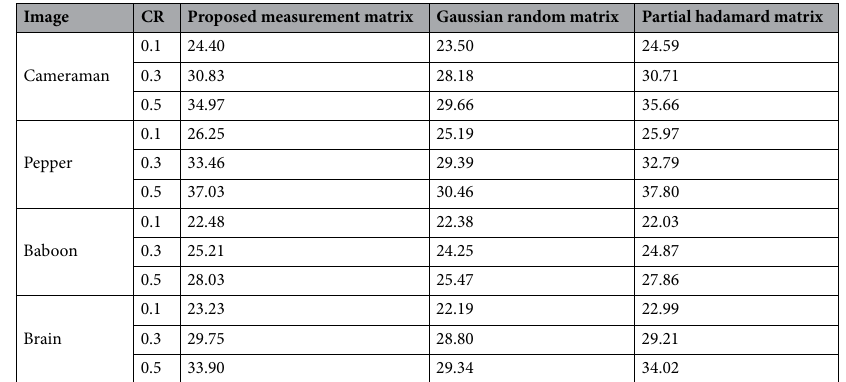
Table 4. PSNR (dB) values of the encrypted images with different measurement matrices.